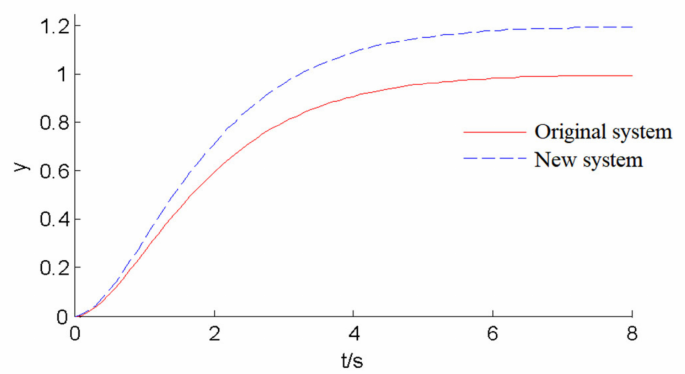
Figure 7. Amplitude Difference of Step Response.